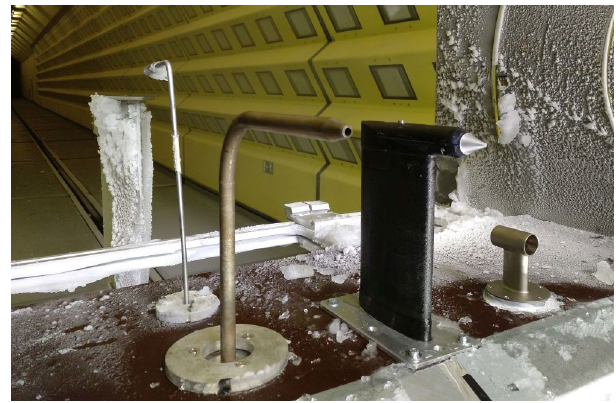
Figure 11. Positioning of the water content probes mounted on the splitter-plate-like panel in the RTA icing wind tunnel test section. Viewing direction is in the direction of flow. From left to right: Cranfield University IKP TW and backward-facing BWV inlet, PA hygrometer IKP, and SEA